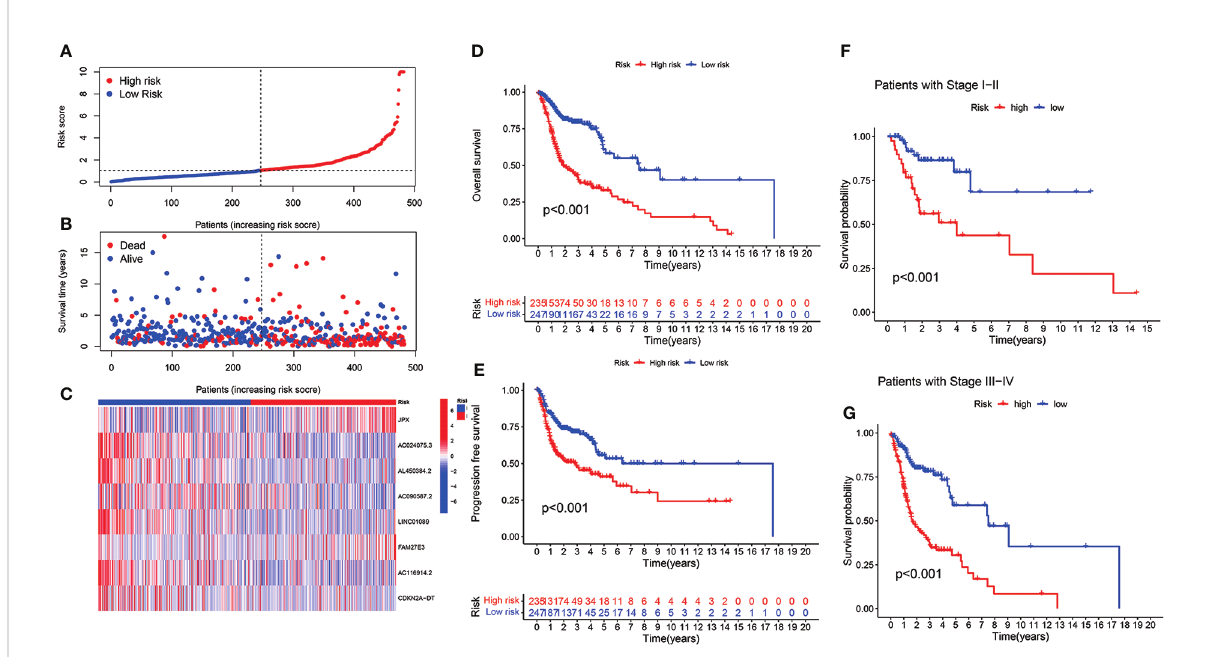
FIGURE 3 The eight cuproptosis-related lncRNAs prognostic value in TCGA entire cohorts. The survival time and risk score correlation analysis (A) The cuproptosis-related lncRNA model-based risk score distribution. (B) The survival status and time differences among both groups. (C) The eight prognostic lncRNAs expression standards for every patient are shown in the clustering analysis heatmap. (D, E) OS and PFS Kaplan-Meier survival curves for both groups of patients. (F, G) In TCGA entire cohorts, OS differences in Kaplan-Meier curves strati fi ed by stage between the two risk